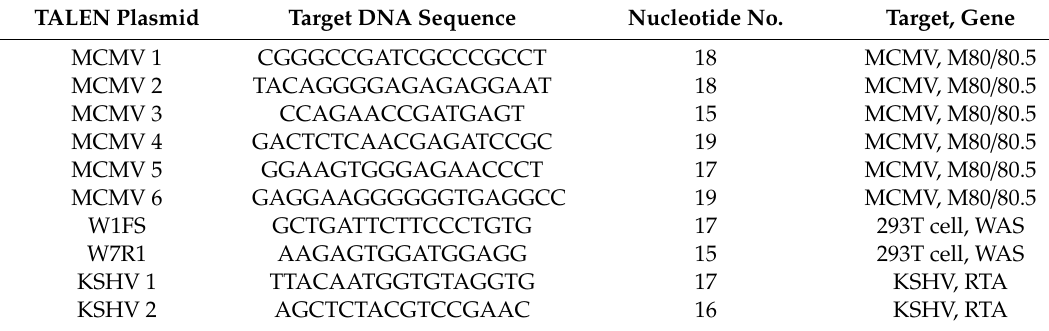
Table 1. List of TALEN